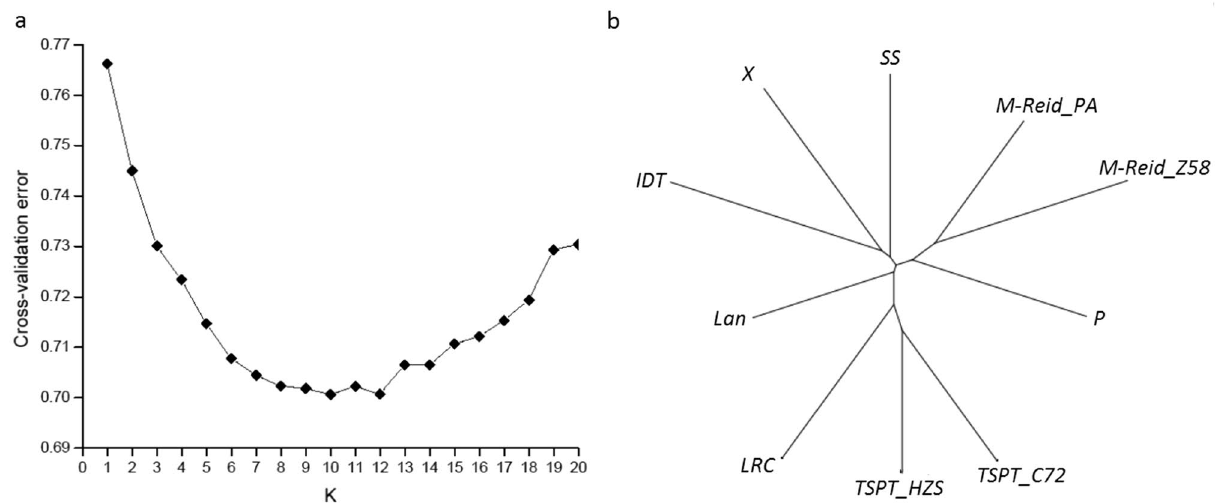
Figure 3. The cross-validation error with different K. ( a ) the best K value is 10; ( b ) Genetic differentiation among 10 subgroups based on pair-wise Fst To identify the optimal K, K values ranging from 1 to 20 were set up to run ADMIXTURE 1.3.0 software, the cross-validation error curve based on ADMIXTURE output (Fig. 3a) , shows that cross-validation error value of 0.701 was smallest at K = 10 (Fig. 3a), thus, dividing the 490 inbred lines into 10 groups (that is, 10 heterotic subgroups) is optimal. Table S1 is the ADMIXTURE output at K = 10. Each inbred line was assigned a set of 10 Q values and a Group ID or heterotic subgroup ID by Default based on the maximum Q value (Table S1). An adjusted Group ID (called